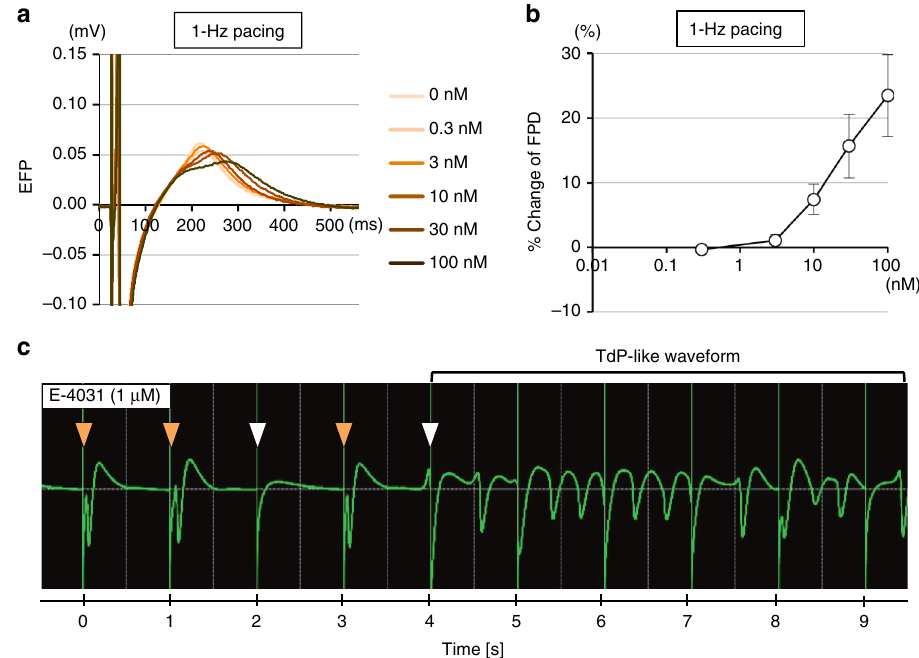
Fig. 4 Drug-induced TdP-like EFP waveforms in CTSs under 1-Hz pacing. a Overlaid EFP waveforms at each E-4031 dosage under 1-Hz pacing. FPD prolongation is observed. b Relative change in FPD after E-4031 treatment under 1-Hz pacing ( ± s.d., n = 4). c Representative TdP-like waveforms after E-4031 treatment (1 μ M) under 1-Hz pacing. The white arrowhead shows transient pacing failure that is not followed by electrical excitation of the CTS. The orange arrowhead shows pacing success followed by electrical excitation of CTS. The fi rst pacing failure resulted in short-long-short sequence-like waveforms Table 2 Change of fi eld potential durations after E-4031 treatment in 1-Hz paced CTSs with 50%